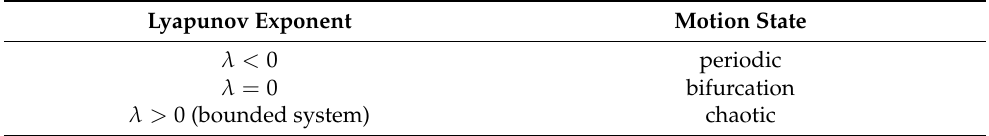
Table 1. The motion states corresponding to different Lyapunov